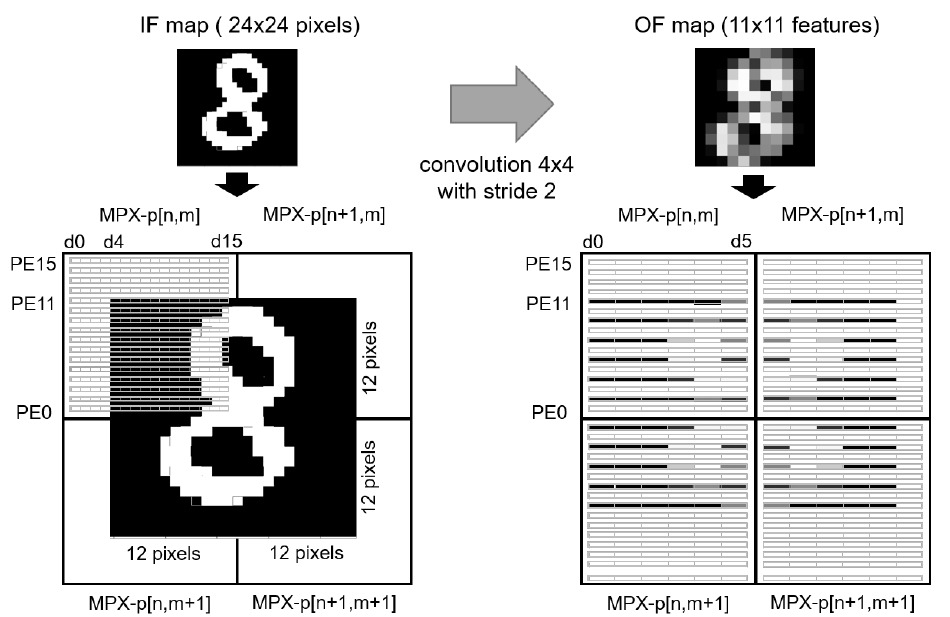
Figure 3. Example of how the input and output feature maps are distributed over four MPX-p in the CONV1 layer. The left-hand side image shows the input MNIST digit spanning four